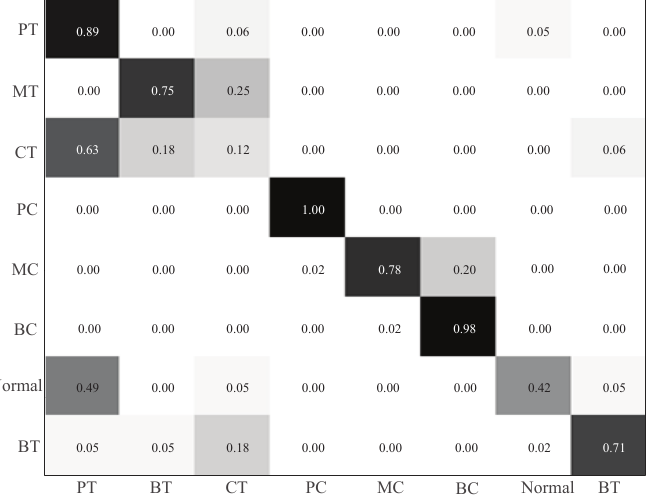
Figure 12. The classification results using Vib-CNN